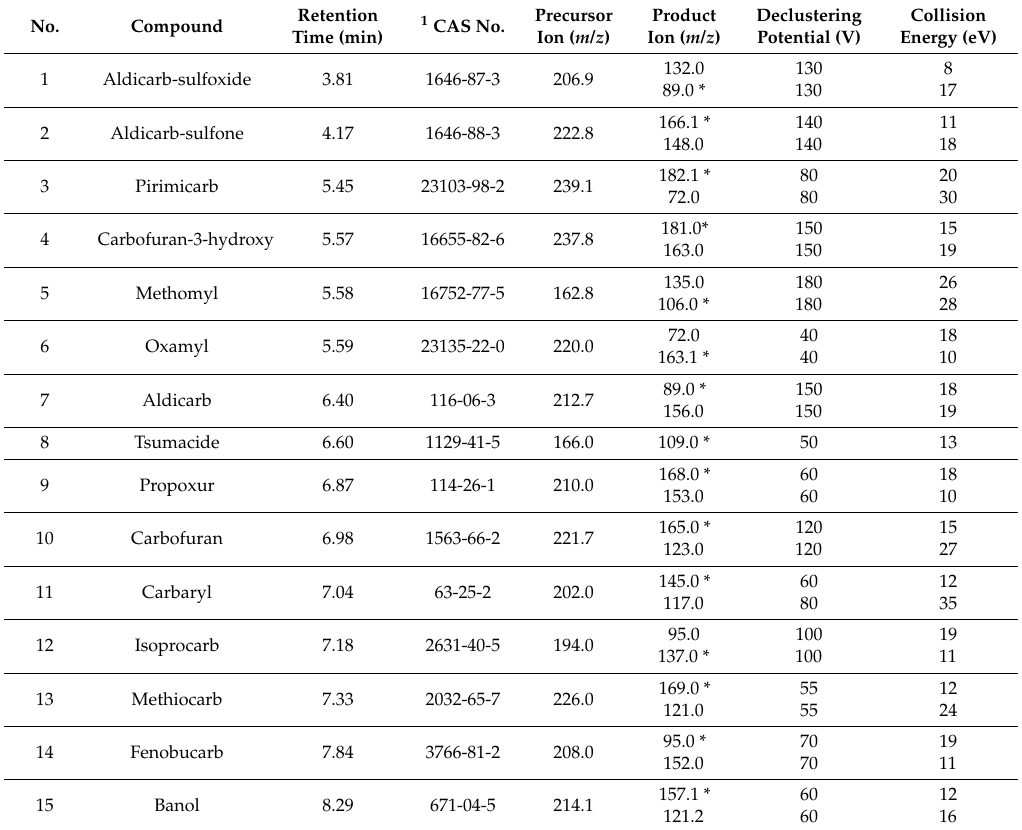
Table 2. Retention time and MS parameters of the fifteen carbamates pesticides.